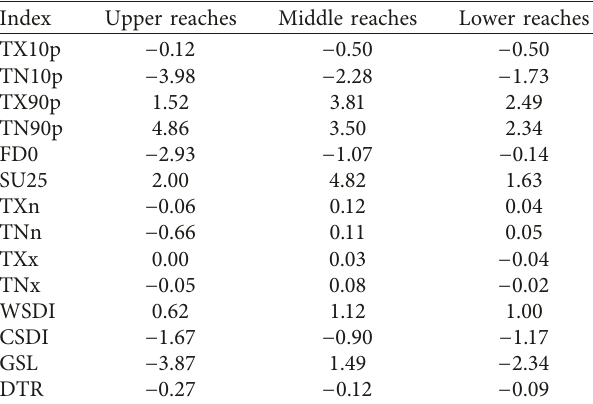
Table 3: Mean values of trends in the upper, middle, and lower reaches of the Minjiang River Basin from 1961 to 2016 ( ° C/10a or d/